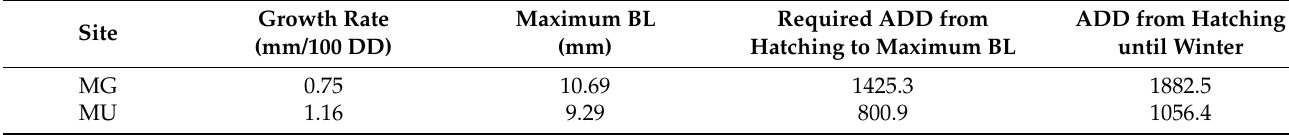
Table 3. The growth rate and maximum body length (BL) of Nannophya koreana larvae and the accumulated degree day (ADD) requirement from hatching to maximum size, and the ADD from hatching to winter at the two study sites (MG: Mungyong-si; MU: Muui-do). Growth Rate Maximum BL Required ADD from ADD from Hatching Site (mm/100 DD) (mm) Hatching to Maximum BL until Winter MG 0.75 10.69 1425.3 1882.5 MU